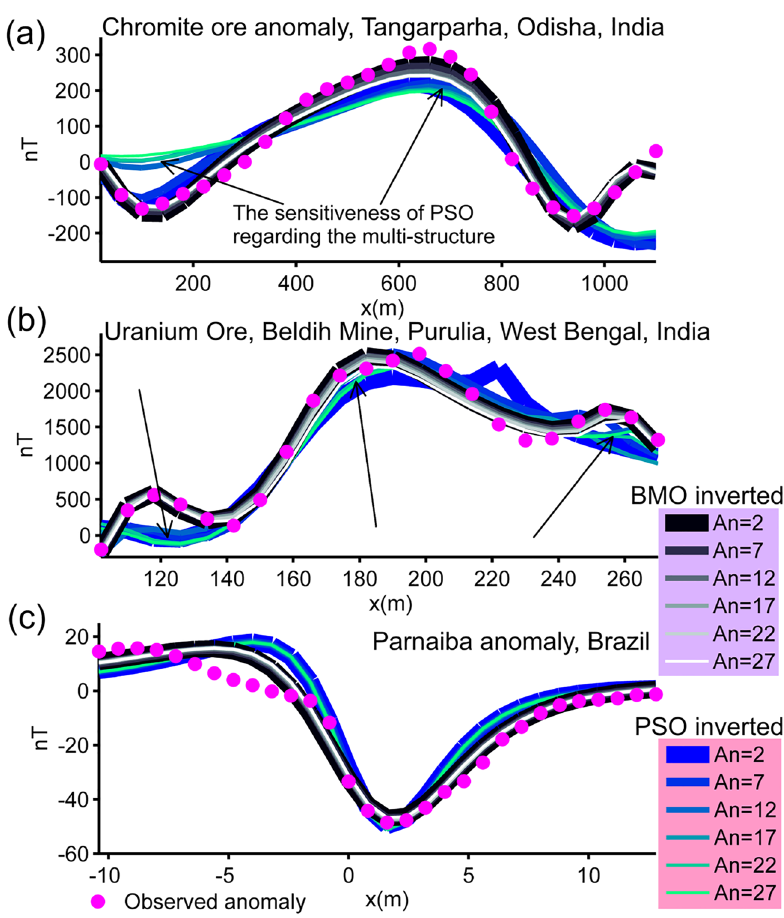
Figure 18. Post-inversion uncertainty appraisal analyses of field data sets using computed mean responses of BMO and sPSO with different An . ( a ) chromite ore anomaly, India, ( b ) uranium ore anomaly, India, ( c ) Mesozoic dyke anomaly,